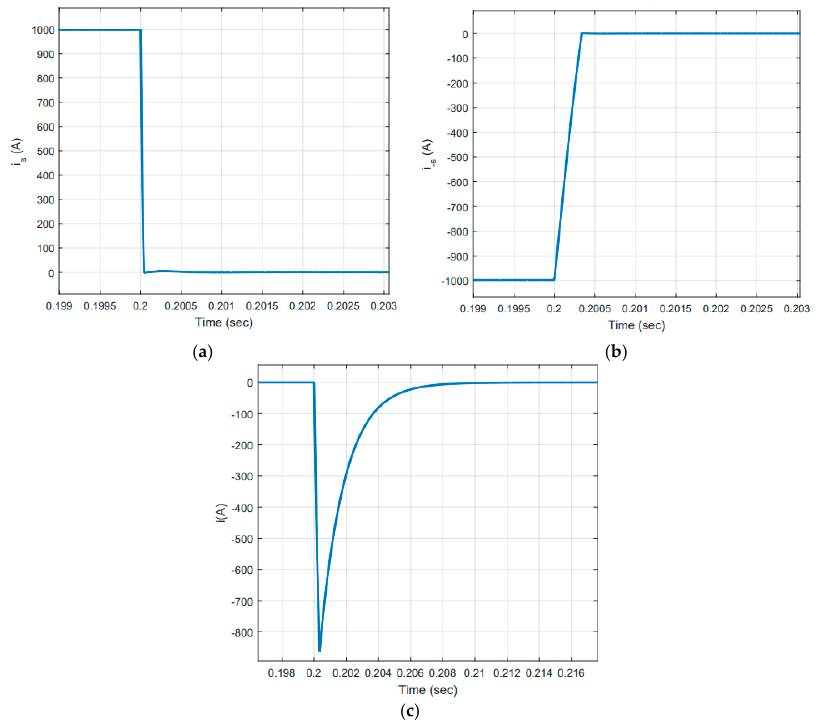
Figure 9. Positive pole-to-ground fault. ( a ) Positive pole current, ( b ) negative pole current, and ( c ) terminal capacitor current. Inventions 2021 , 6 , 18